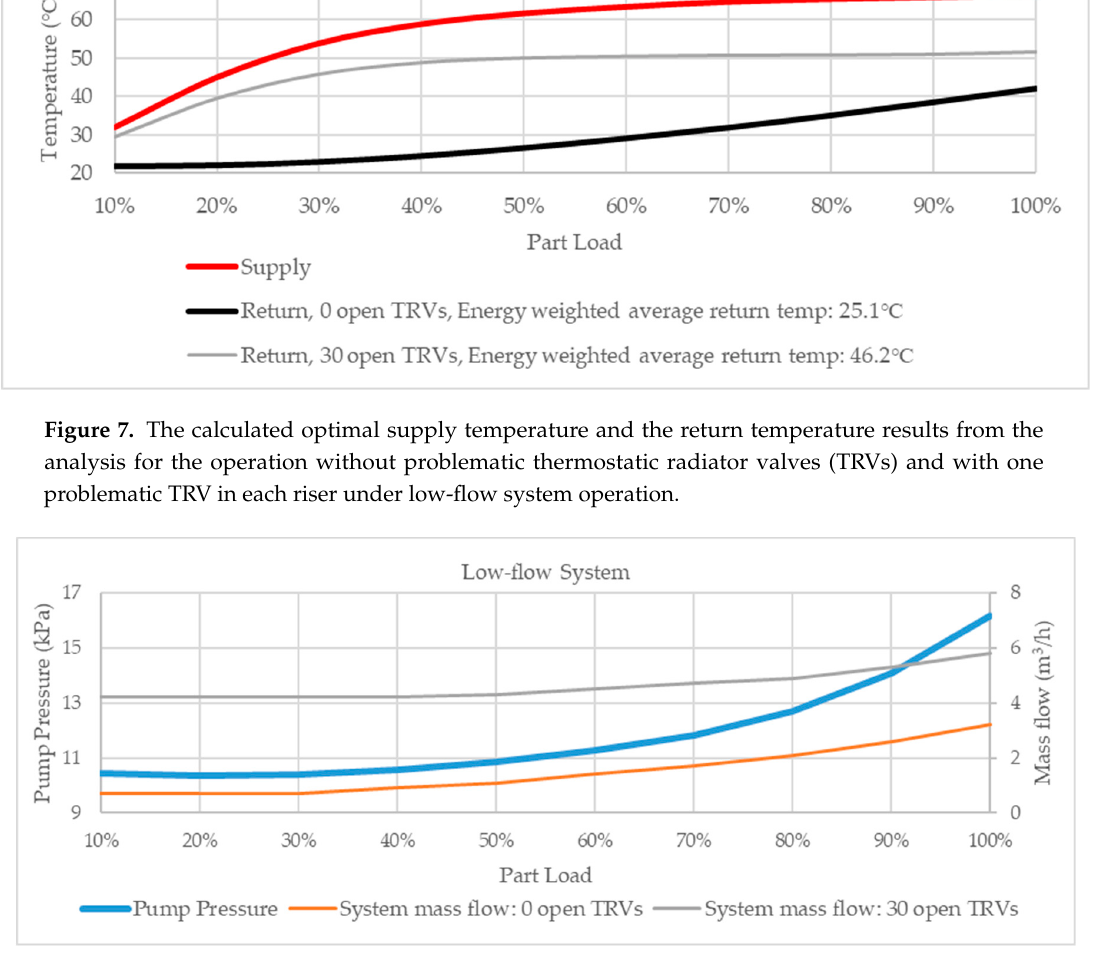
Figure 8. The minimum pump pressure difference required and the system mass flow rate for the operation without problematic TRVs and with one problematic TRV in each riser under low-flow system operation.